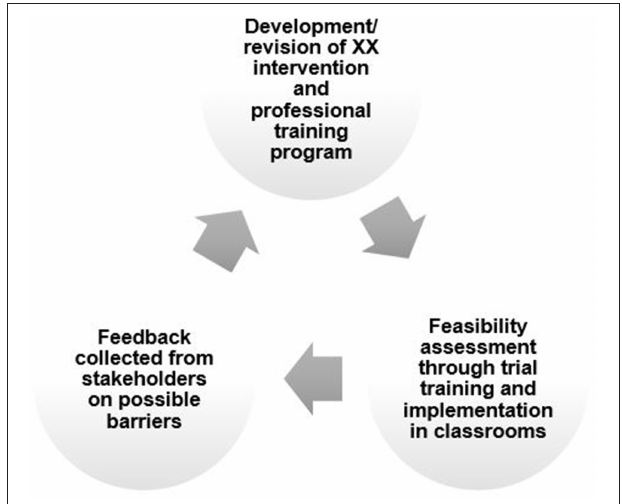
FIGURE 1 | Iterative Process (repeated during the first 2 years of the 3-year